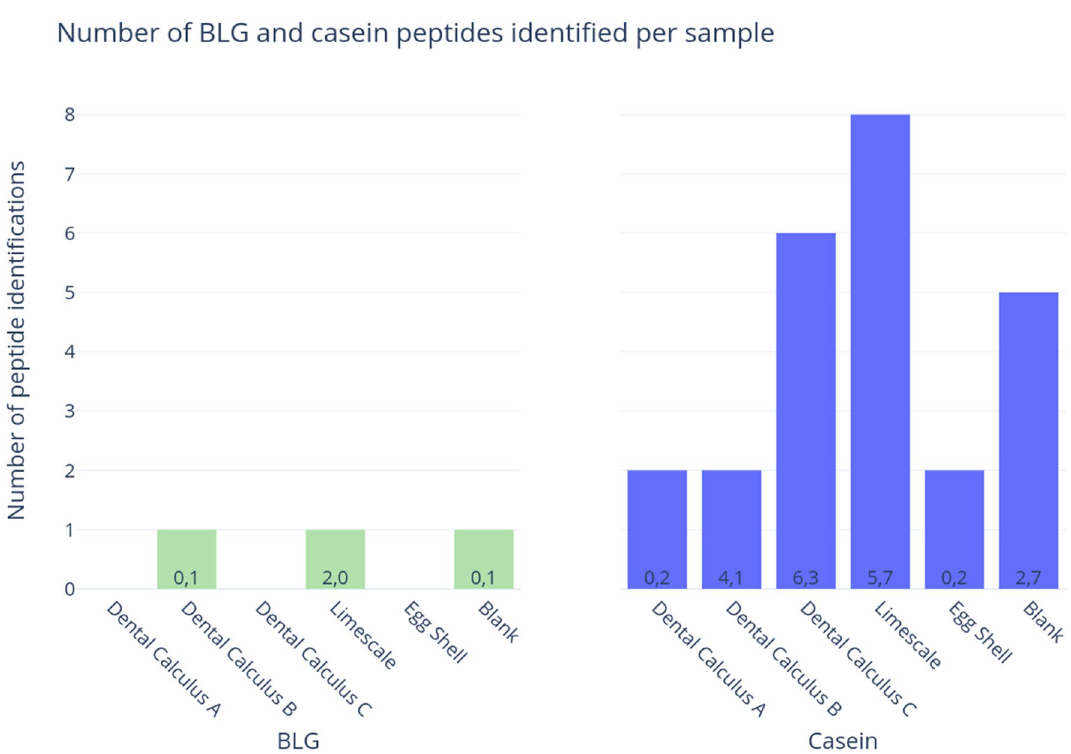
Figure 3. Number of BLG and any casein peptides identified in experimentally contaminated samples (extracted and analyzed in this study) according to MaxQuant’s ‘razor and unique peptides’ output. The number of asparagine and glutamine (respectively) residues in all peptides in each category is shown in the